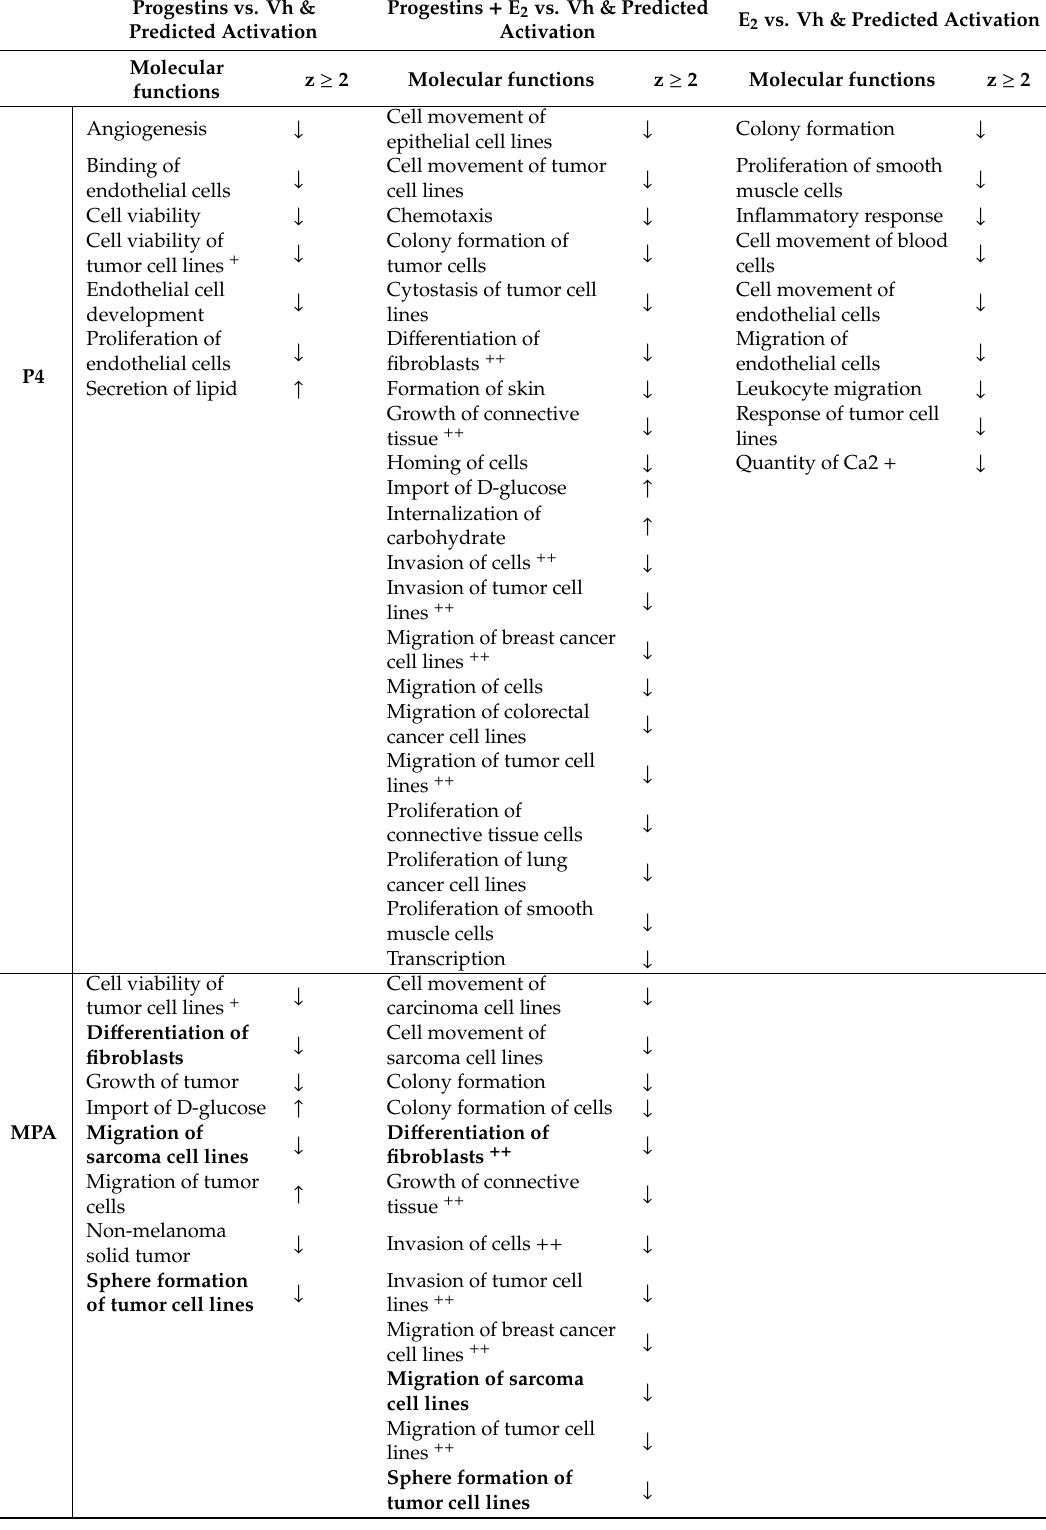
Table 3. Common and unique molecular functions of progesterone and testosterone structurally related progestins in the absence or presence of E 2